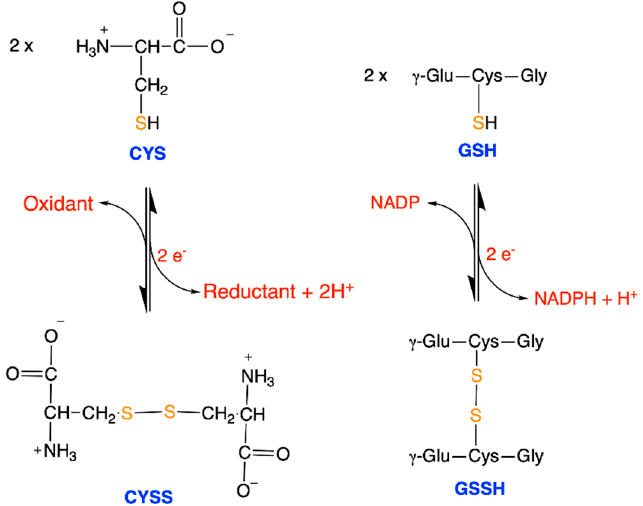
Figure 6. Structures of cysteine (CYS)/cystine (CYSS) and reduced glutathione (GSH)/oxidized glutathione (GSSG). Both reactions are very similar, consist in the formation of a disulfide bond from cysteine thiols and involve the transfer of two electrons and 2 H + (or H − and H + , depending on the molecular mechanisms involved).